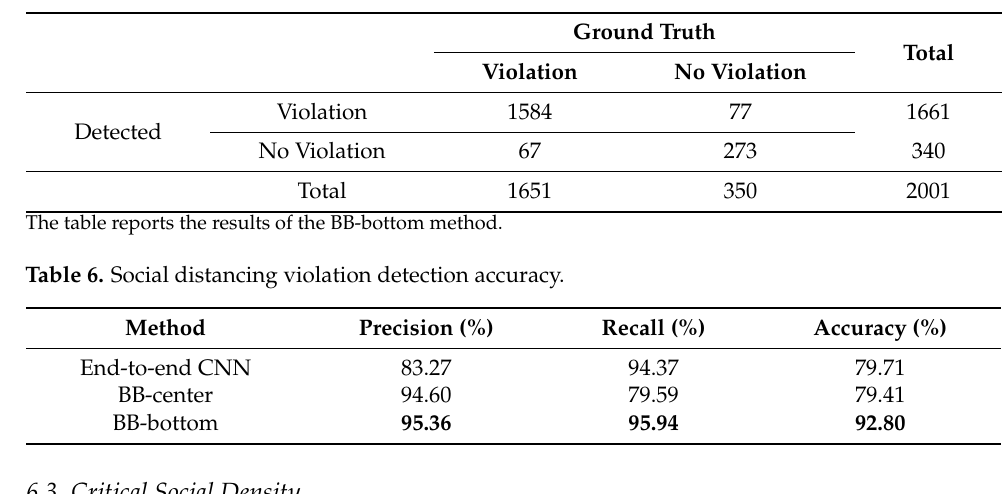
Table 5. Confusion matrix of social distancing violation detection.